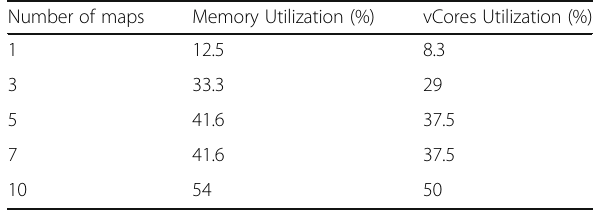
Table 6 Cluster resource utilization during classification